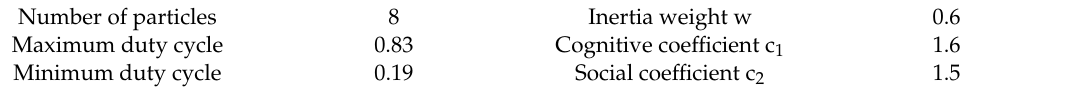
Table 4. Operational parameters of the particle swarm optimization (PSO)-based GMPPT method.